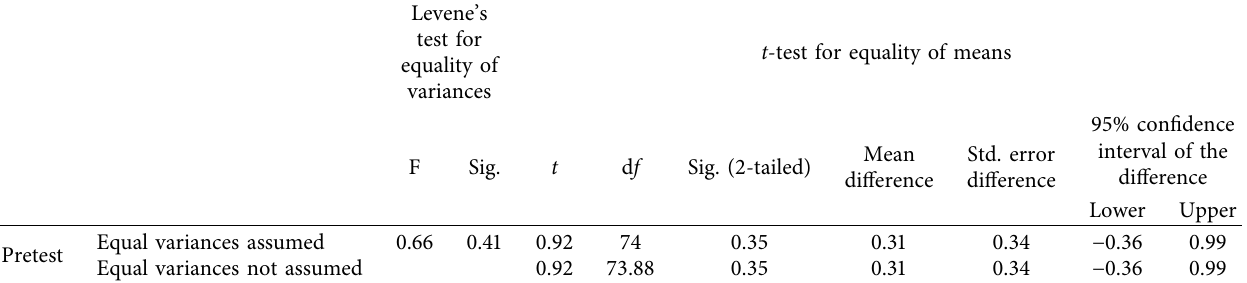
Table 3: Independent samples t -test (pretest scores of EG and CG).